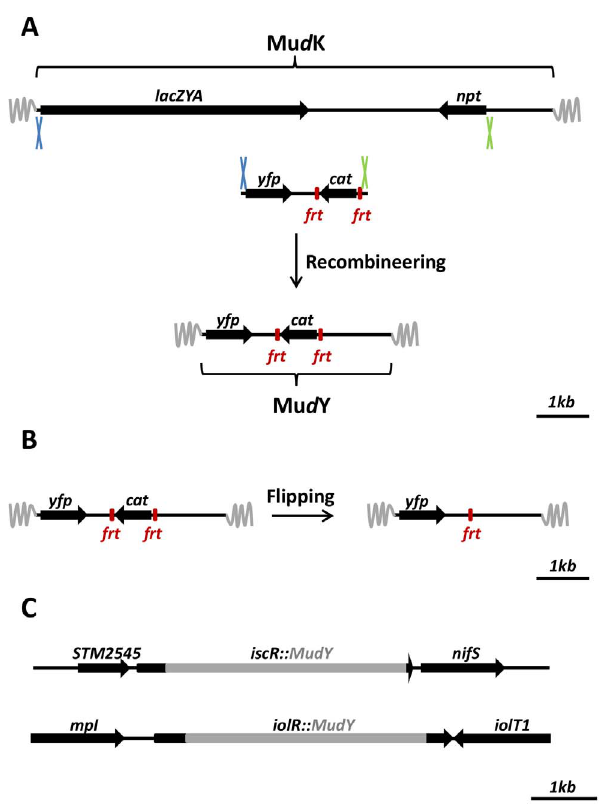
Figure 1. Construction and use of the MudY transposon. (A) During construction of the Mu d Y transposon, the lacZYA - npt of Mu d K was replaced by an yfp - frt - cat - frt module through recombineering (blue and green crosses indicate the homologous regions involved in recombination). (B) The frt - cat - frt cassette can be readily flipped out using the Flp recombinase, thereby reducing possible polar effects of the cat marker. (C) Exact location and genomic context of two Mu d Y insertions ( iscR ::Mu d Y and iolR ::Mu d Y) in LT2 yielding endogeneous nucleoid reporters.